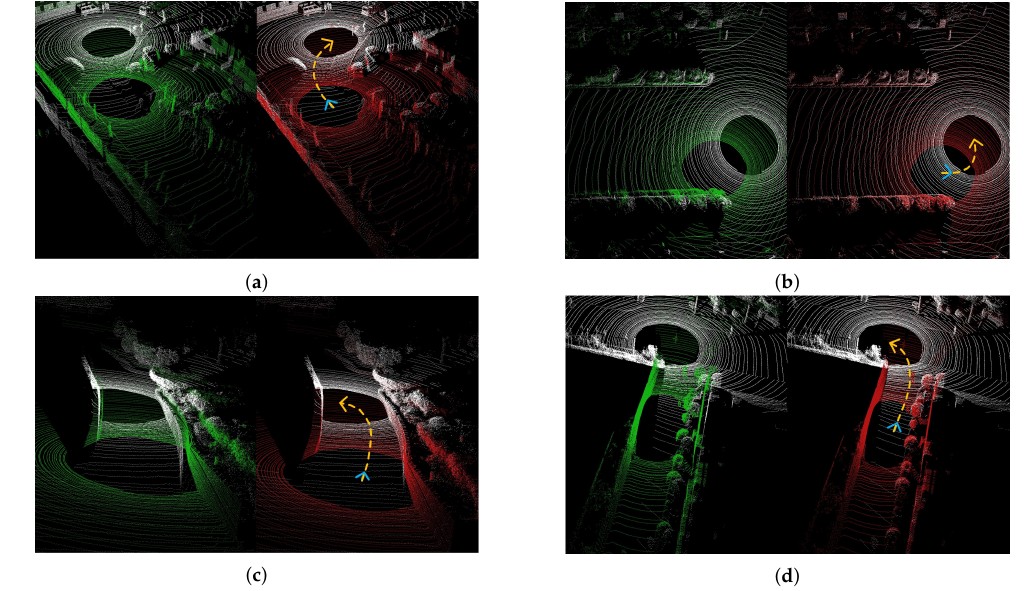
Figure 7. Four typical lidar pairs chosen to perform the hand–eye calibration. In each sub-figure, the left part is the registration result before the hand–eye calibration, whilst the right half is the result after hand–eye calibration. The yellow dotted line indicates the movement trajectory of the vehicle, while the yellow arrow and the blue arrow denote the orientation of the vehicle.